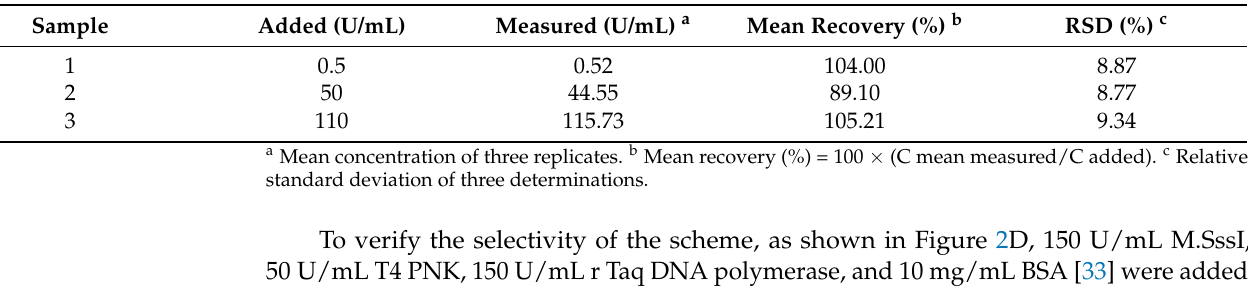
Table 1. Recovery studies of M.SssI in CutSmart buffer.